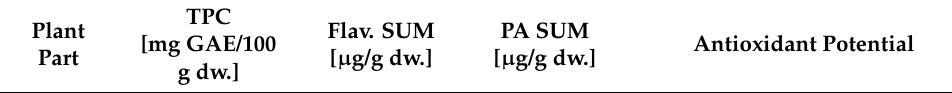
Table 3. Total phenolic content (TPC), sum of flavonoids and phenolic acids, and antioxidant activity of methanolic extracts from different morphological parts of Atriplex sagittata Borkh. TPC Flav. SUM PA SUM Plant Antioxidant Potential [mg GAE/100 [ µ g/g dw.] [ µ g/g dw.] Part g dw.] DPP FRAP HmmolTrolox/ 100 g dw.) 100 g dw.]